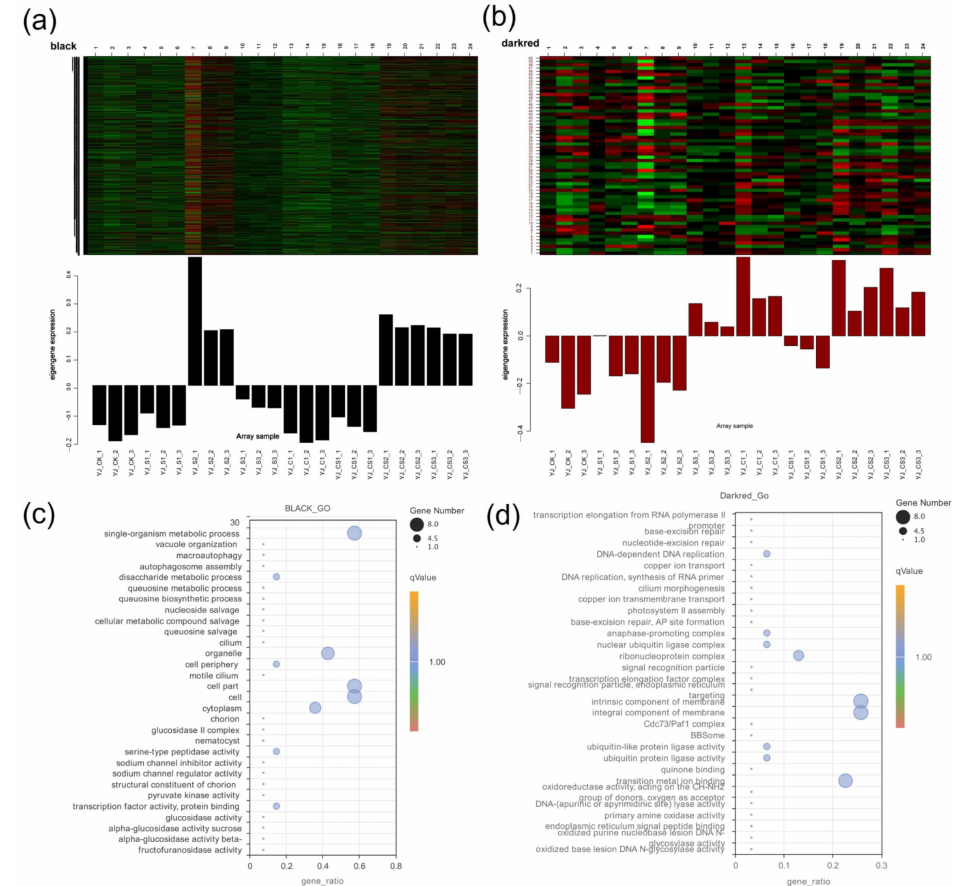
Figure 11. The expression patterns of genes related to Cd and Se distribution in B. juncea seedlings in Black and Darkred modules. In the heat map, red represents upregulated genes, black represents neutral genes, and green represents downregulated genes. Bar plots show eigengene values (i.e., the first principal component) calculated from the singular value composition. ( a ) The expression pattern of genes related to the distribution of Cd and Se in the Black module; ( b ) the expression pattern of genes related to the distribution of Cd and Se in the Darkred module; ( c ) the GO enrichment analysis of DEGs in the Black module; and ( d ) the GO enrichment analysis of DEGs in the Darkred